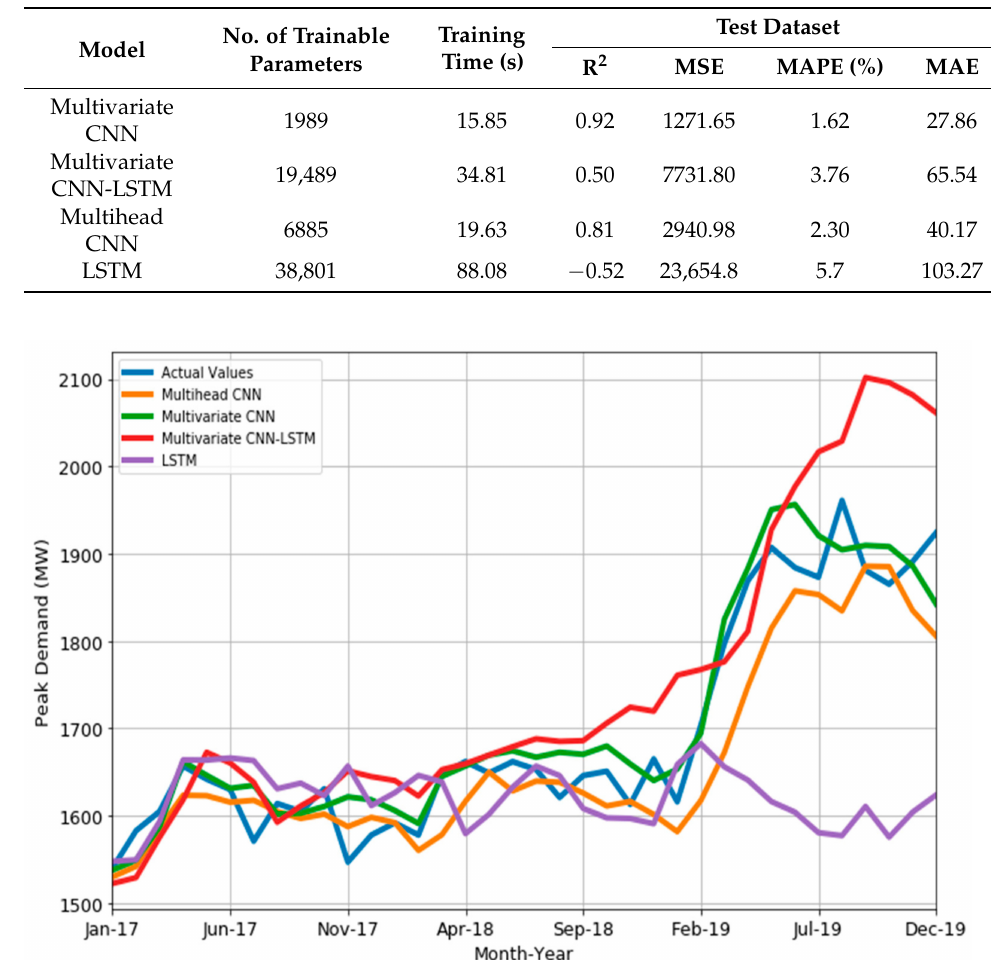
Figure 16. Comparison of CNNs and LSTM on the test